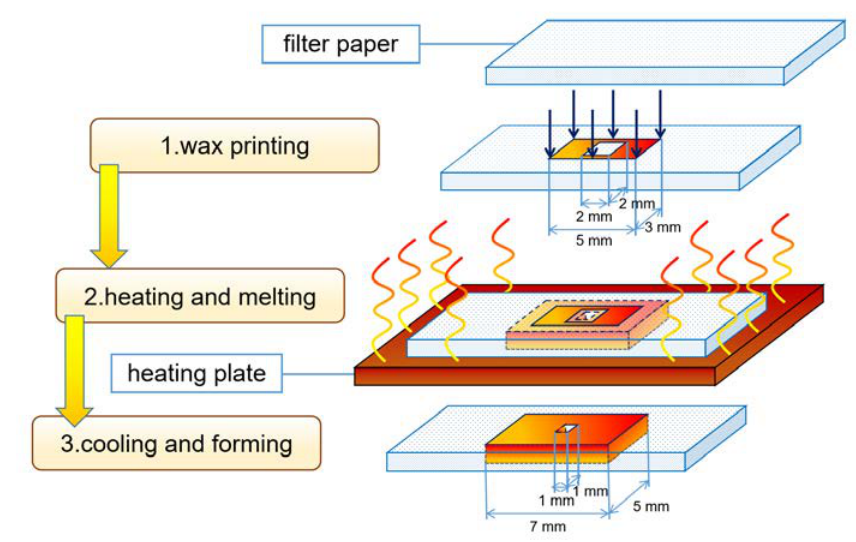
Figure 2. Schematic diagram of paper chip prepared by wax printing.